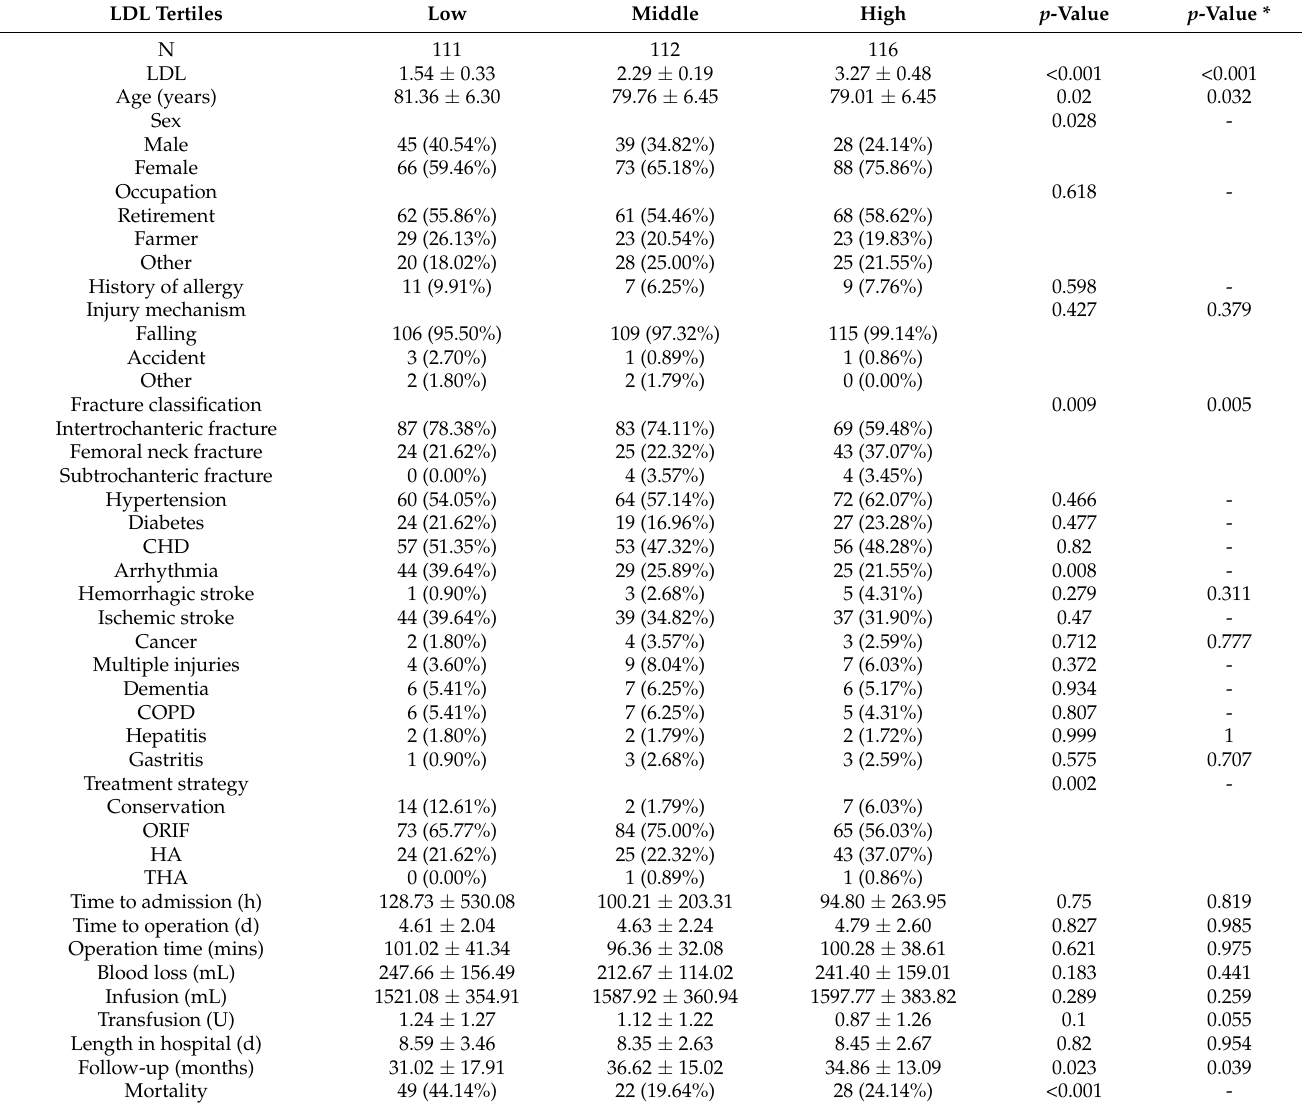
Table 1. Demographic and clinical